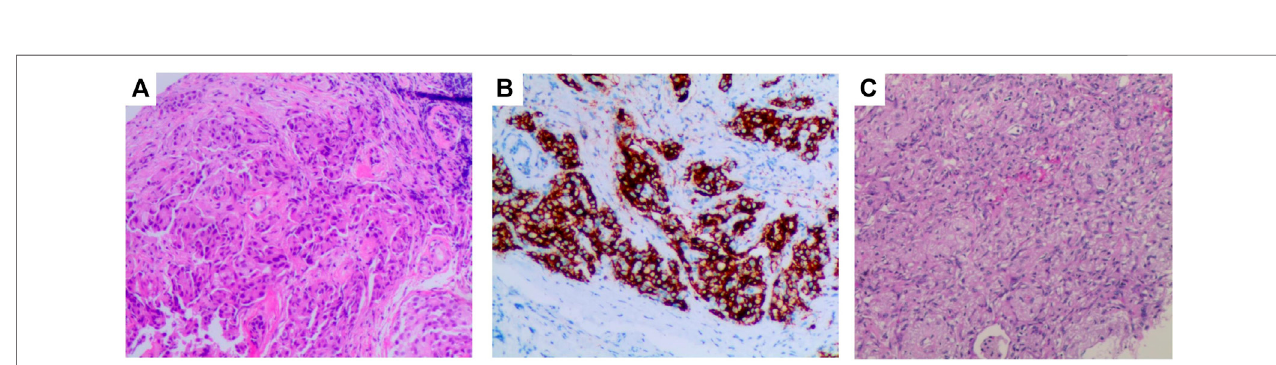
FIGURE 1 | pCR to neoadjuvant alectinib in resectable ALK-positive NSCLC. Contrast-enhanced CT of the chest before neoadjuvant therapy showed an approximately 4.2×3.4 cmmassintheright hilumwithlocalizedobstructivepneumoniaintherightlowerlobe (A) and enlargedR4lymph node (B) ;Contrast-enhanced CTofthe chest after neoadjuvanttherapy showed anapproximately1.2× 1.1 cmmassintheright hilum, withatumor shrinkage of90% (C) and 0.6×0.6 cmR4lymph node, with a shrinkage of 50% (D) ; Contrast-enhanced CT of the chest at the 8-month follow-up showed no local replase (E,F) .